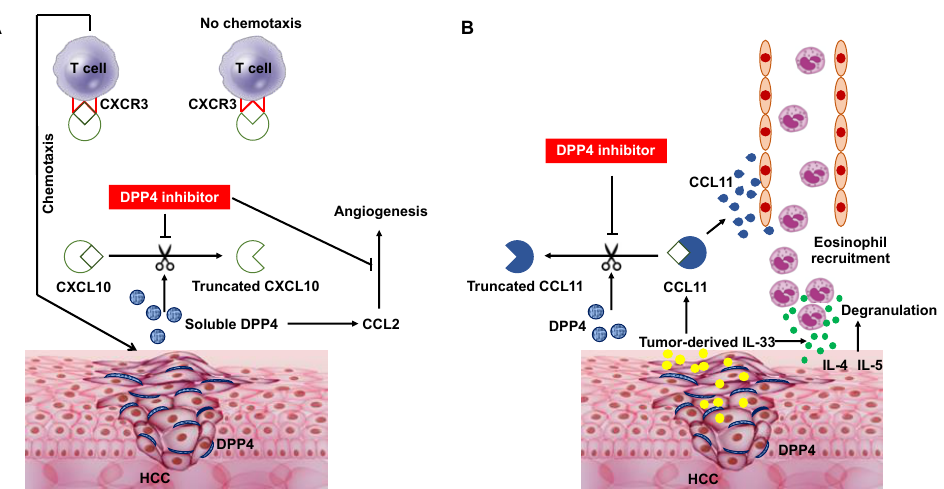
Figure 2. Schematic diagram depicting DPP4 inhibitor-mediated T cell chemotaxis activation and angiogenesis inhibition ( A ), and eosinophil recruitment ( B ). ( A ) DPP4 expression and the soluble DPP4 concentrations are increased in tumor tissue and serum in HCC patients, respectively. Inhibition of DPP4 enzymatic activity enhances anti-tumor effects by preventing the biologically active form of CXCL10 from being truncated by active DPP4 and increasing lymphocyte trafficking into the tumor. DPP4 inhibitor treatment also inhibits angiogenesis by downregulating chemokine ligand 2 (CCL2) expression induced by soluble DPP4. ( B ) CCL 11, an eosinophil-selective chemokine in the eotaxin subfamily, is induced by tumor-derived IL-33, which also stimulates eosinophil degranulation and recruits eosinophils toward HCC tumors. CCL11 is cleaved by DPP4 into a truncated form (CCL11 3–74 ) with diminished chemoattractant properties. Consequently, DPP4 inhibitor treatment activates anti-tumor immunity through enhancement of eosinophil migration, independent of lymphocyte trafficking. CXCR3, CXC chemokine receptors